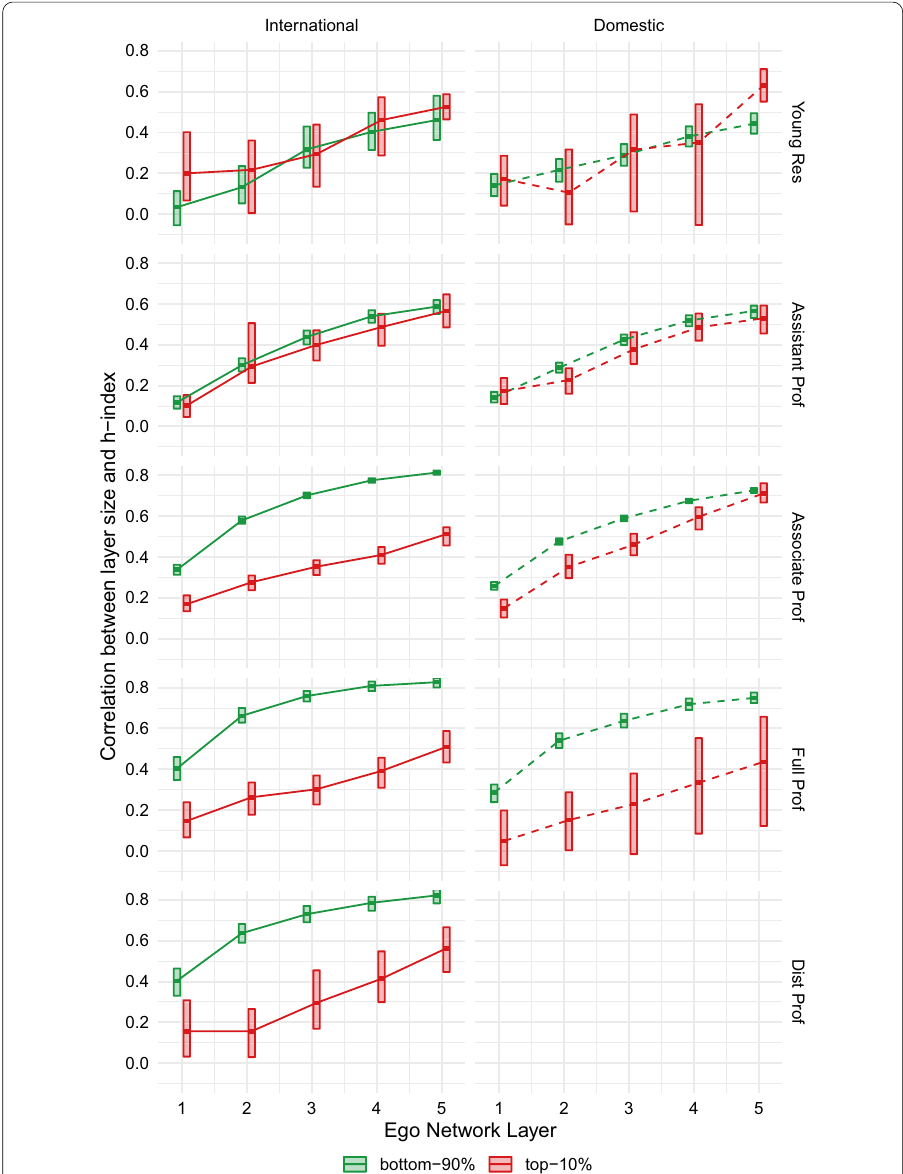
Fig. 15 Highly-mobile researchers: impact and co-authorship ego networks. Correlation between ego network layer size and h-index, for highly mobile authors (red) and regular authors